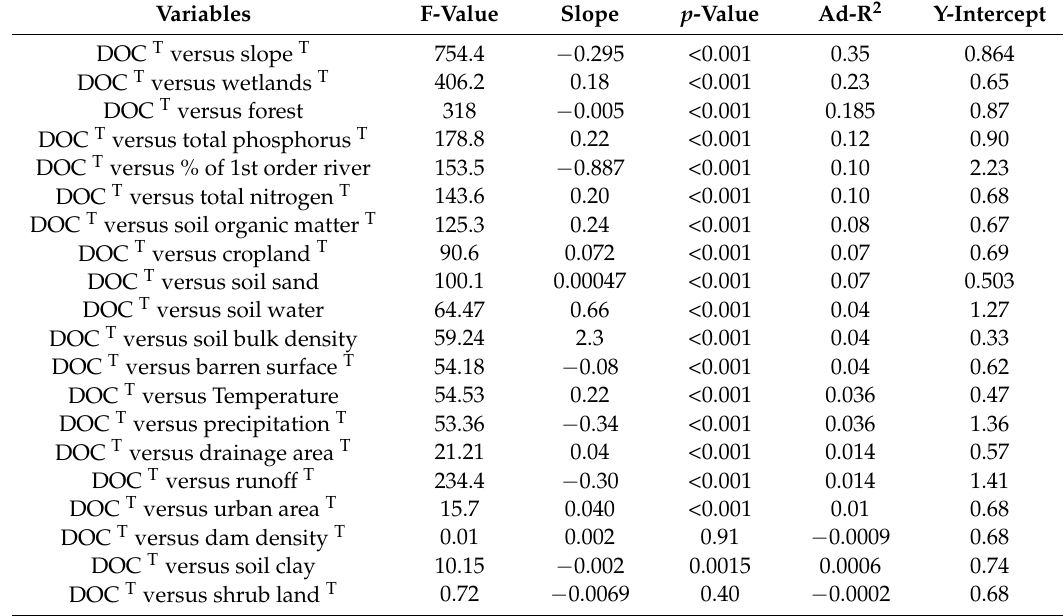
T indicates that variables are log-transformed; Ad-R 2 : adjusted coefficient of